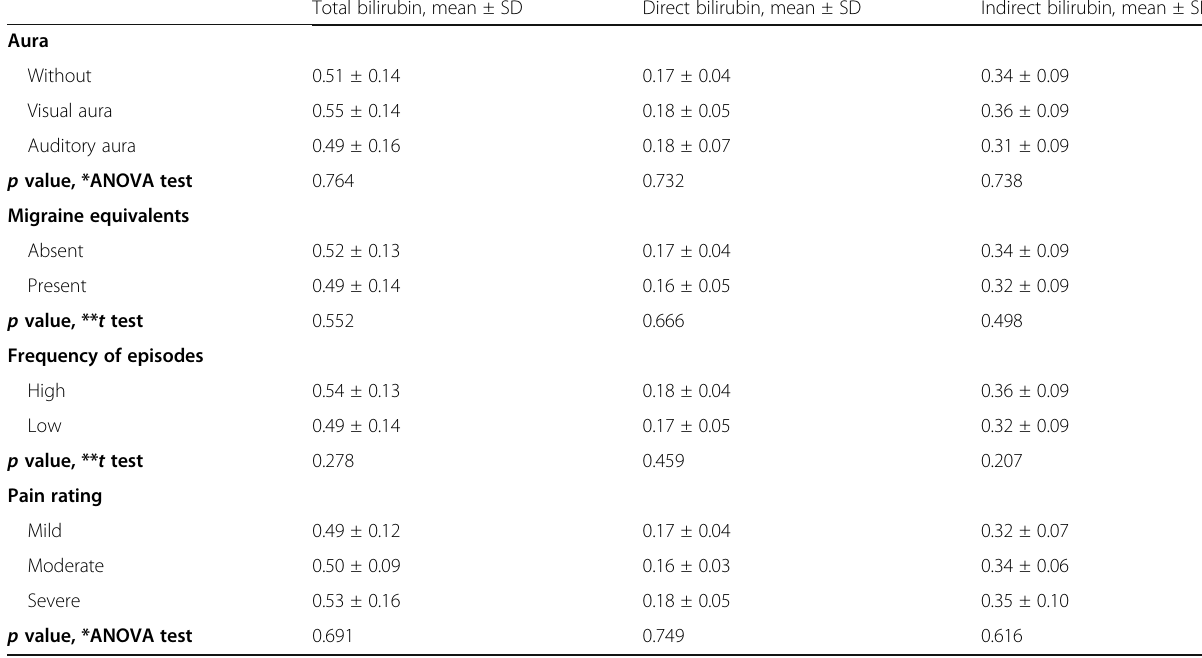
(Table 4). As for BMI, there was an inverse correlation with serum bilirubin; the more the BMI, the less the serum bilirubin (Table 4). During headache attacks, there was no statistically significant difference between migrainous patients with normal EEG findings and those with abnormal EEG findings as regards serum bilirubin concentration (Tbil, Dbil, and Ibil). On the other hand, during headache-free periods, migrainous patients with abnormal EEG findings had statistically significant lower Table 2 The relationship between level of serum bilirubin and migraine headache features Total bilirubin, mean ± SD Direct bilirubin, mean ± SD Indirect bilirubin, mean ±